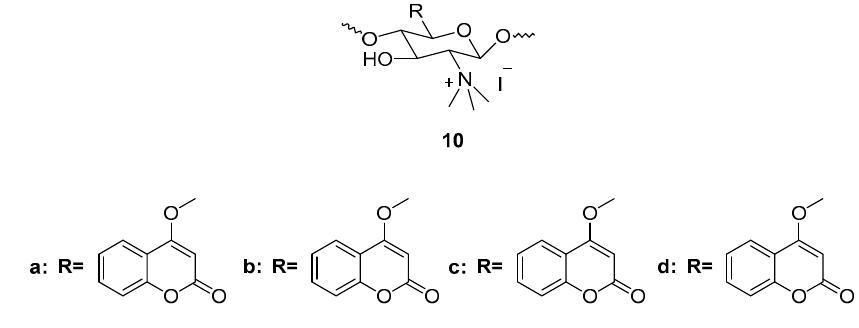
Figure 5. Chitosan derivatives 10a–d.